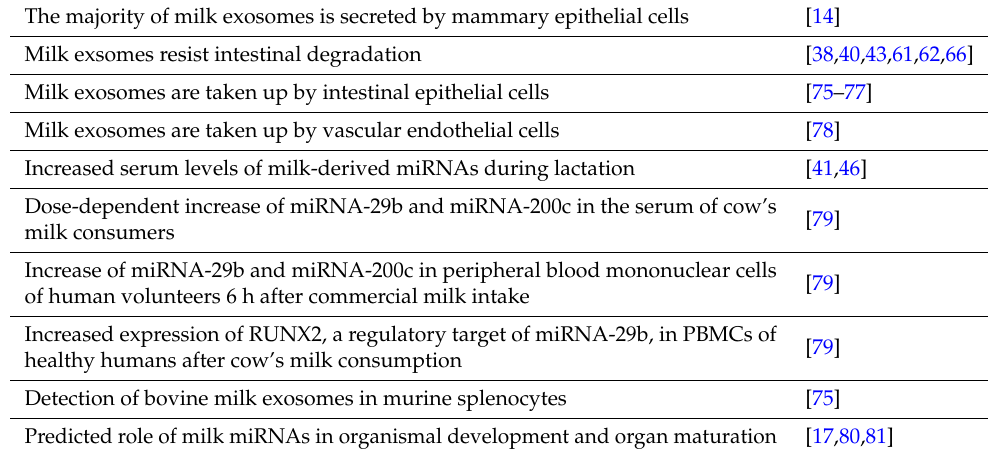
Table 1. Evidence for milk exosome miRNA transfer into the systemic